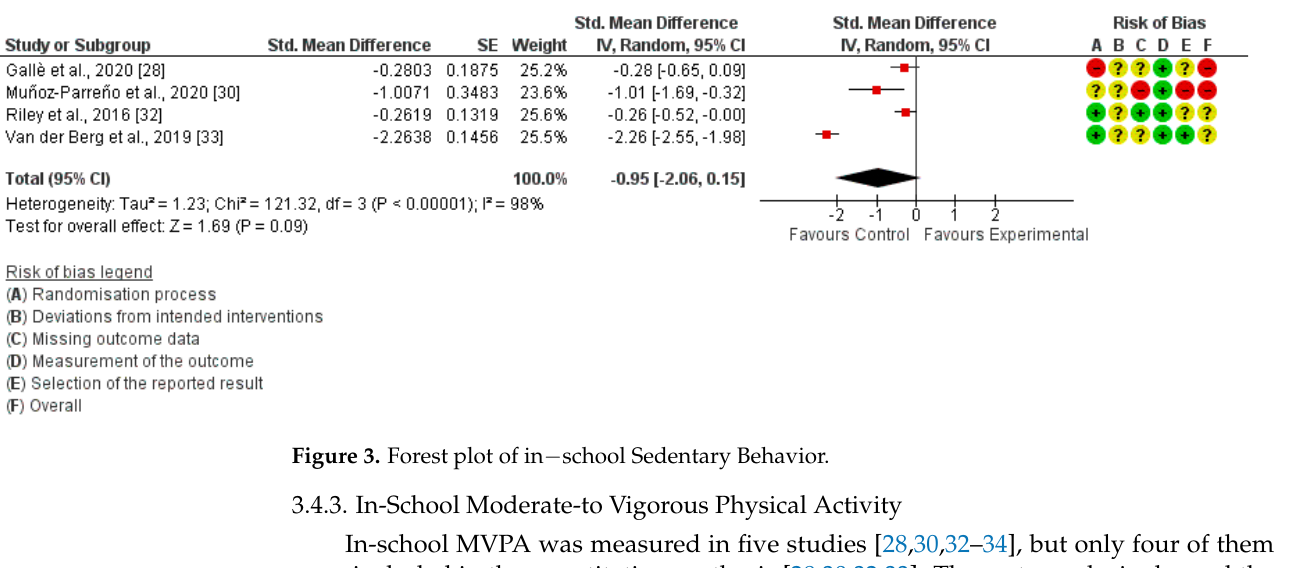
Figure 3. Forest plot of in − school Sedentary Behavior .